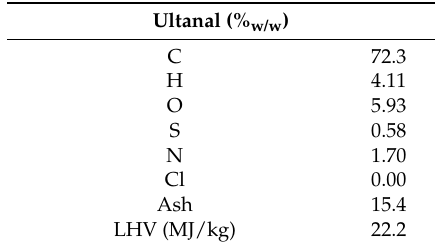
Table 2. Analyses of the bituminous coal used in the